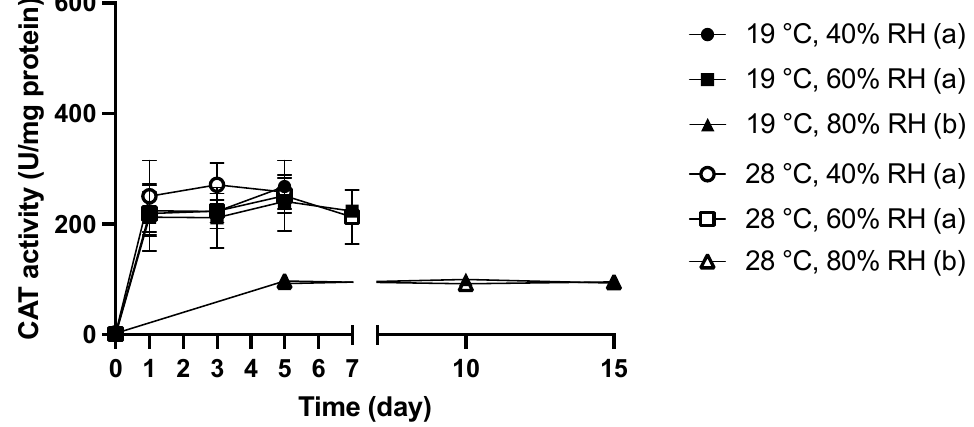
Figure 3. CAT activity of C. cladosporioides spores under wet-dry cycles with different combinations of RH and temperature. The changes in CAT concentration under moisture dynamics were analyzed by repeated measures one-way ANOVA. Grouping was performed by Duncan’s post-hoc test. Letters in parentheses indicate different groupings.